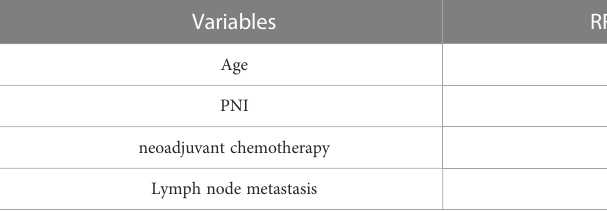
TABLE 3 Multivariate analysis of independent risk factors for BRPC recurrence.